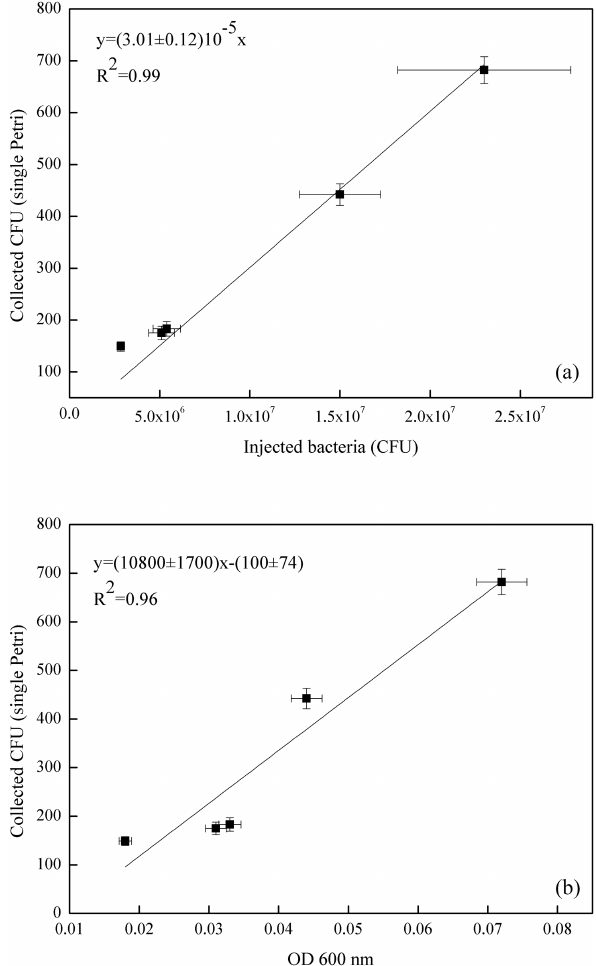
Figure 6. Correlation curve of the average count on the four Petri dishes exposed in each experiment with the number of E. coli bac- teria injected in ChAMBRe (in units of 10 7 CFU, a ) and with the optical density (OD 600nm, b